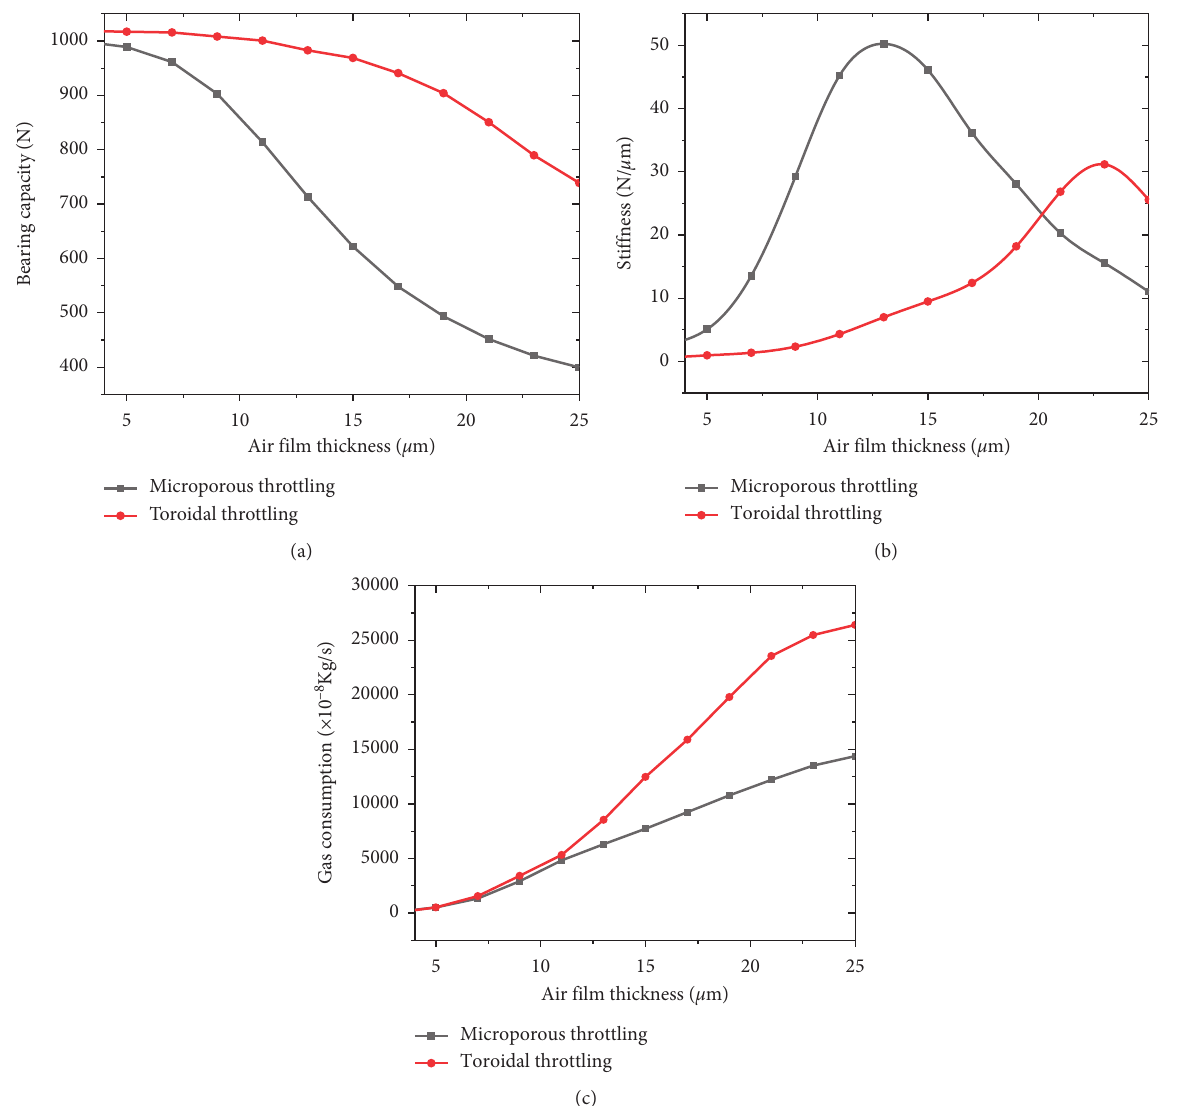
Figure 5: Performance comparison of 2 throttling modes of aerostatic